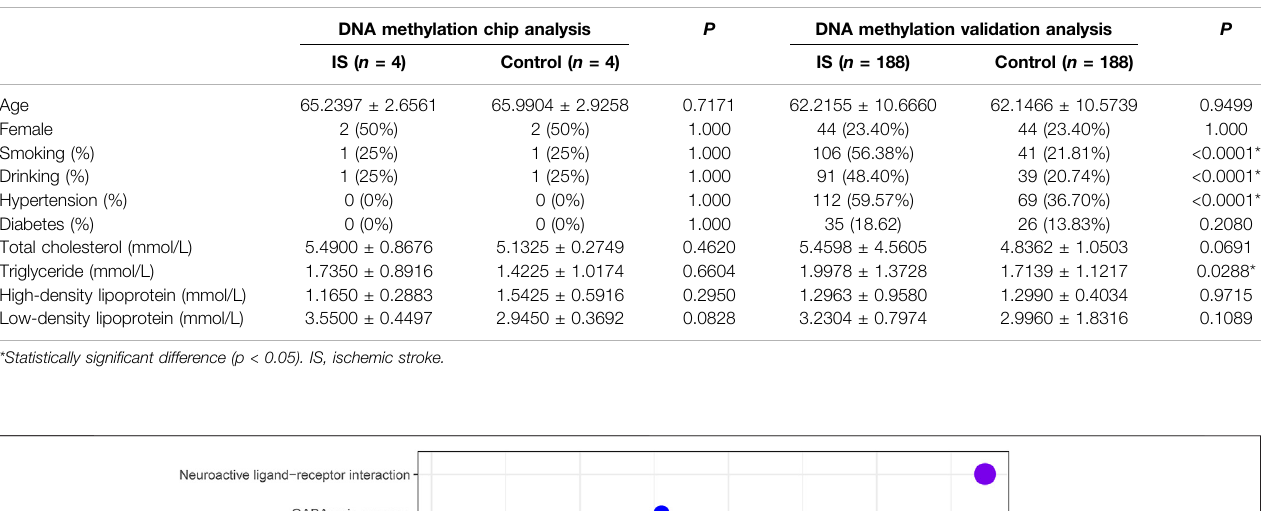
Frontiers in Genetics |